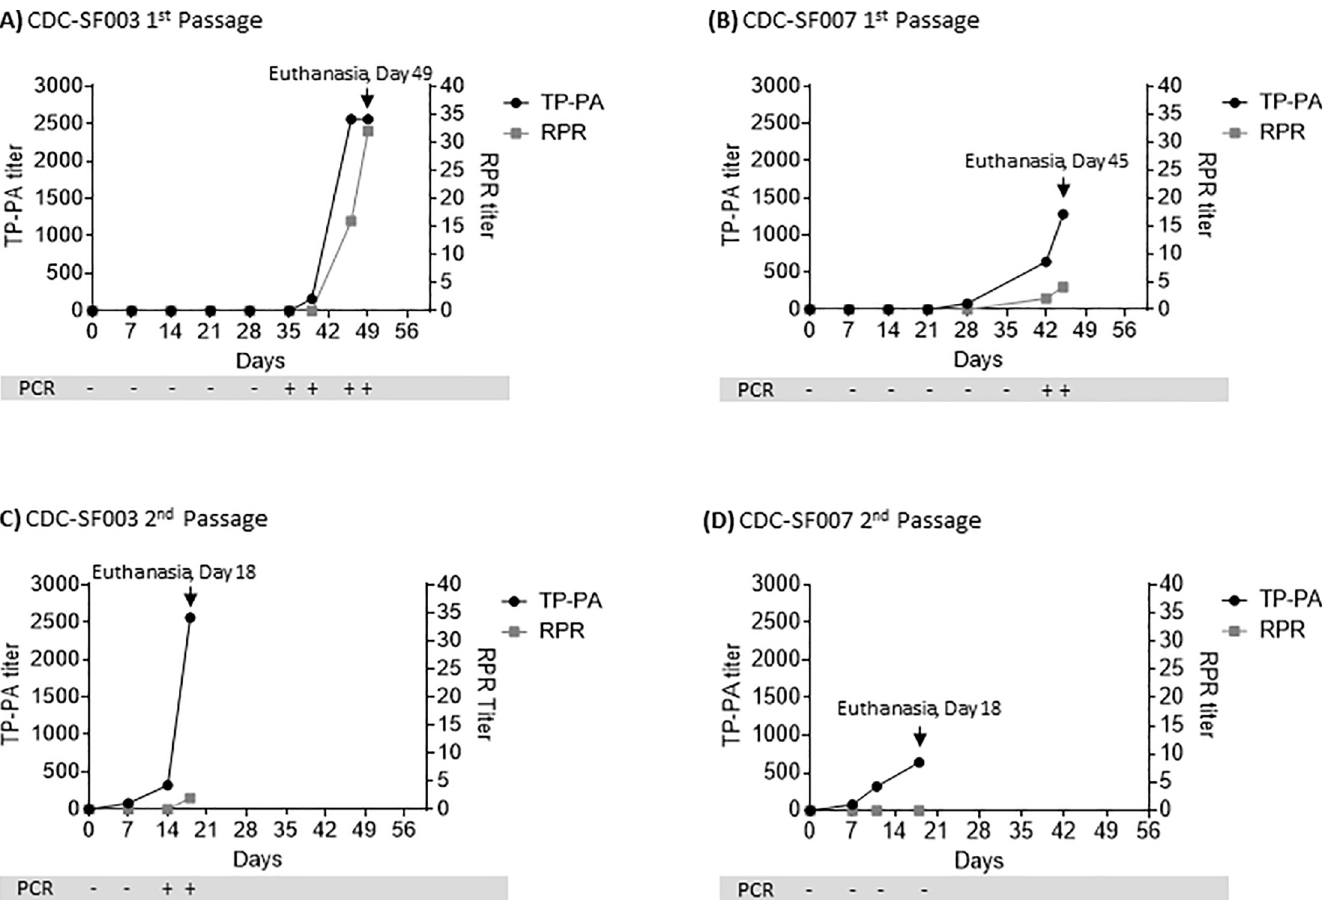
Fig 2. Serology results for successfully propagated specimens. Treponemal (TP-PA, black line, left axis) and nontreponemal (RPR, grey line, right axis) antibody titers in rabbits (N = 1 per passage) that were (A) inoculated IV and IT (0.6 ml inoculum per site) with the patient specimen CDC-SF003 and (B) inoculated IV and IT (0.6 ml inoculum per site) with the patient specimen CDC-SF007. Second passage was then performed for (C) CDC-SF003 inoculated IT with fresh testicular extract (1.5 ml) from the first passage rabbit and (D) CDC-SF007 inoculated IT with previously frozen and thawed testicular extract (1.5 ml) from the first passage rabbit. Whole blood was also analyzed weekly by PCR, with results shown in the grey bars for each time